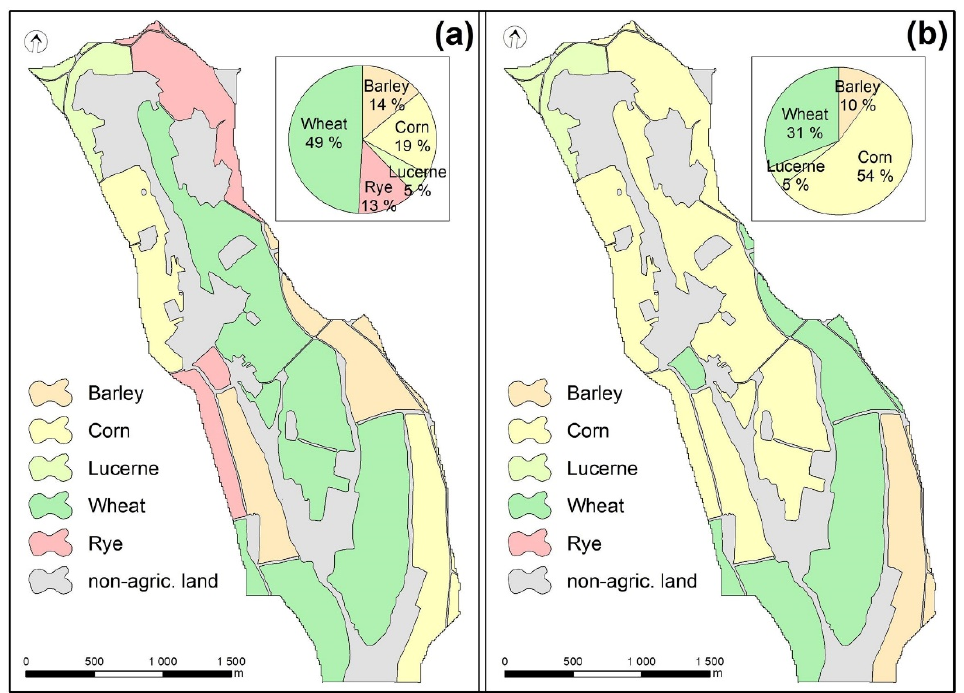
Figure 6. Annual crop distribution in the study area: ( a ) 2015–2016; ( b ) 2016–2017.